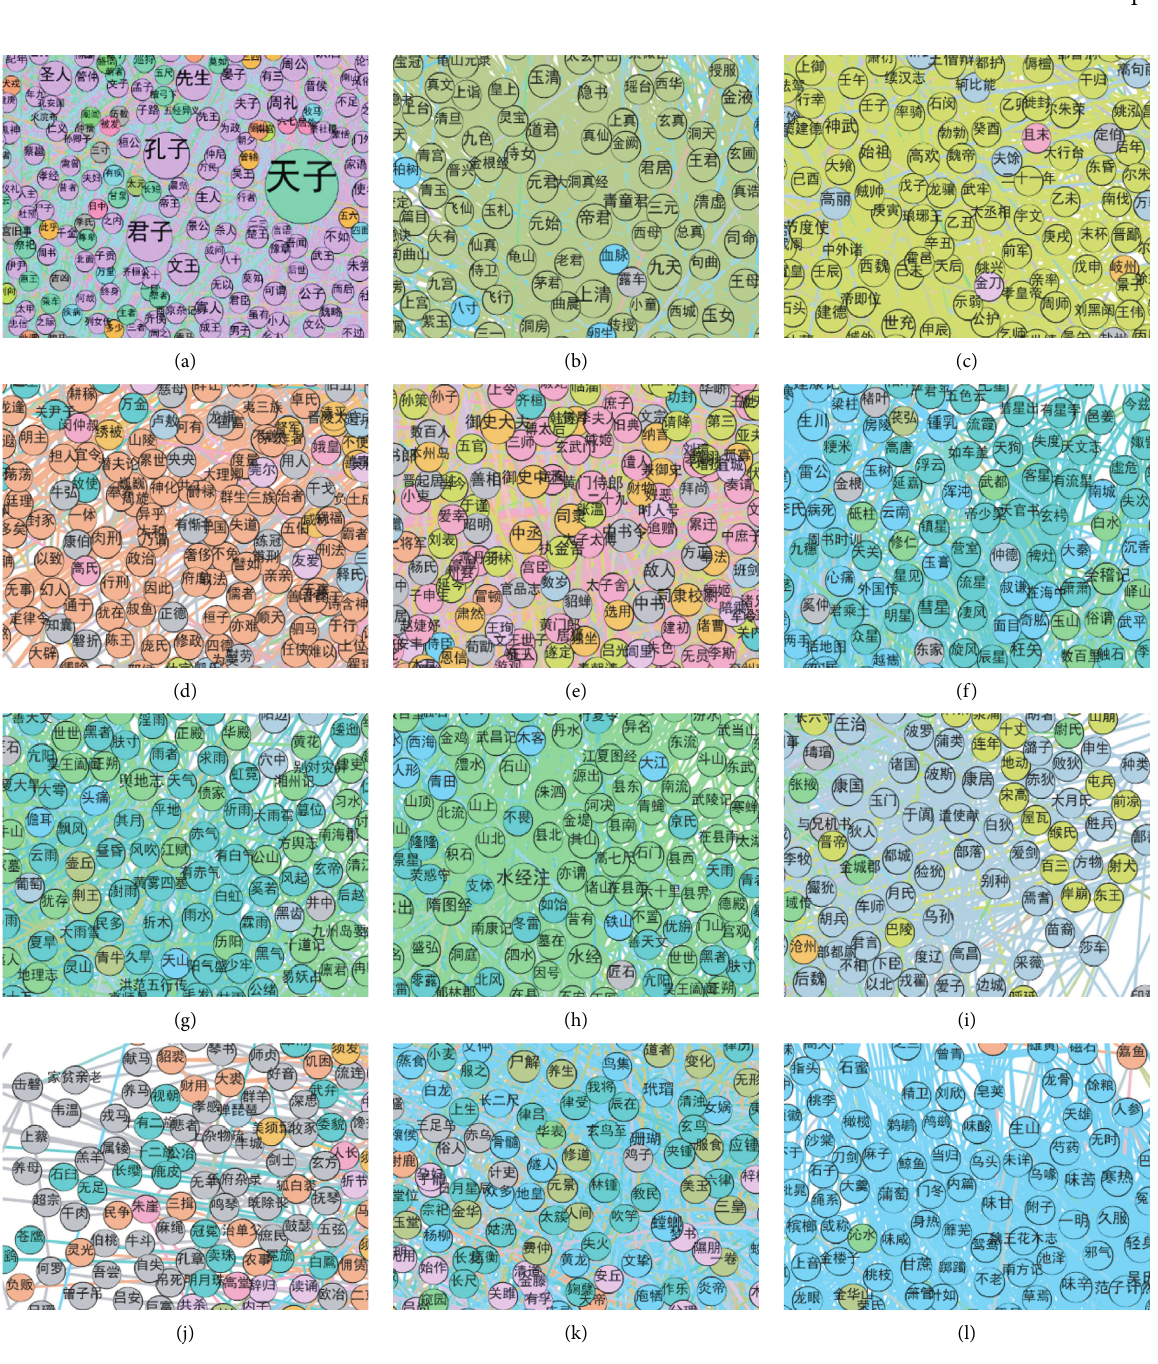
Figure 7: Typical elements in traditional Chinese cultural element complex network’s topics. (a) Confucianism. (b) Taoism. (c) Military and diplomacy. (d) Social rule. (e) Political life. (f) Cosmic astrology. (g) Natural disaster. (h) Landforms and geography. (i) Exotic customs. (j) Craft artifacts. (k) Myths and legends. (l) Natural